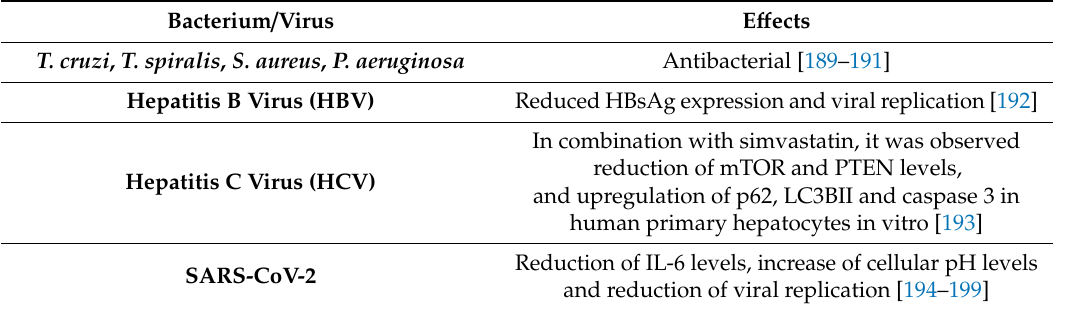
Table 3. Antibacterial and antiviral e ff ects of metformin. Bacterium /